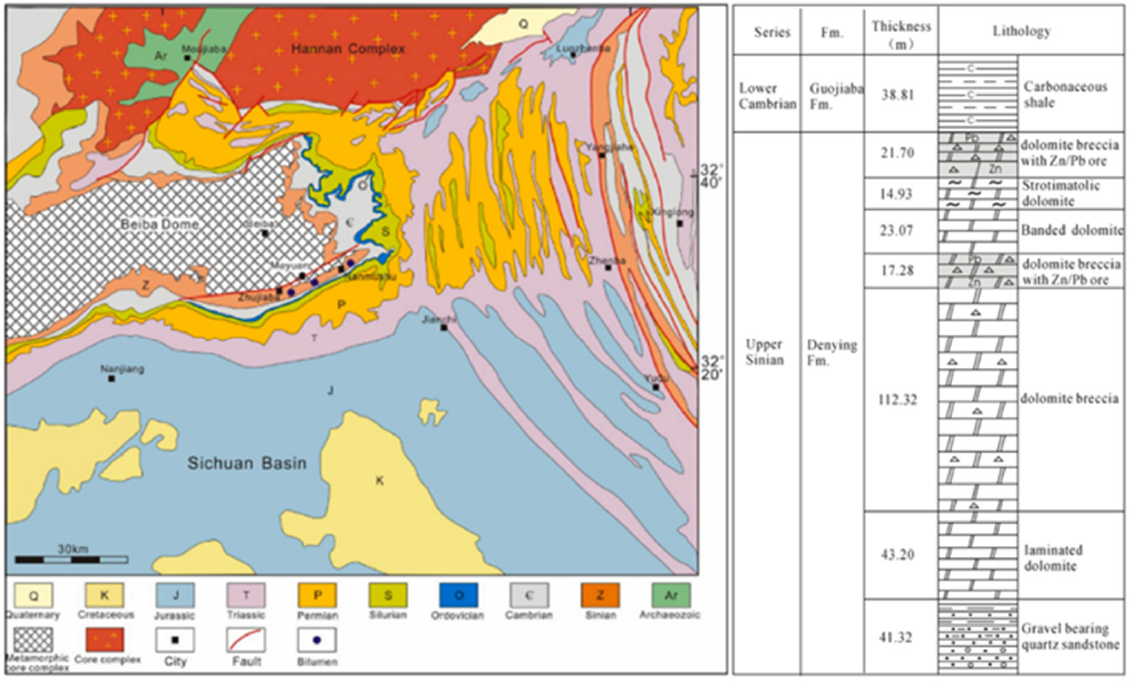
Figure 2. Simple geology map of the Beiba Dome on the northern margin of Sichuan basin, as well as sampling locations in Mayuan.